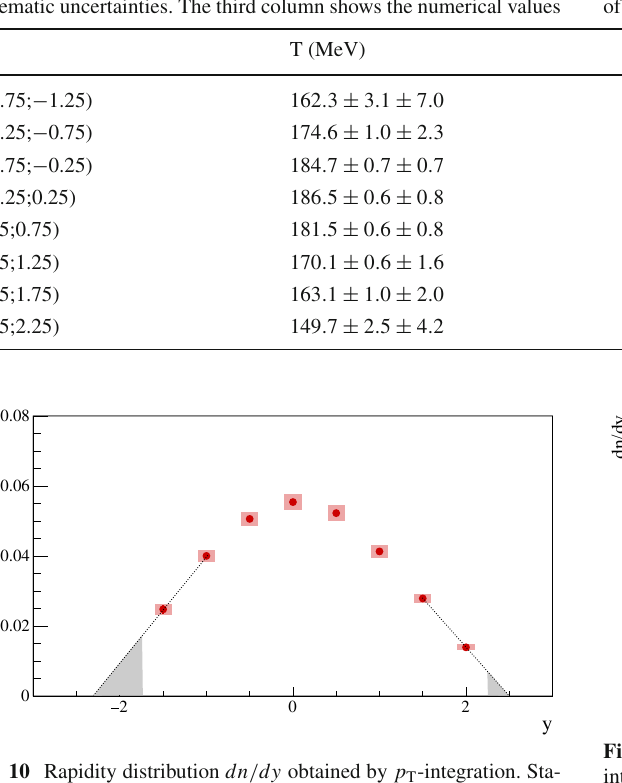
of the p T -integrated yields presented in Fig. 10 with statistical and sys- tematic uncertainties. In the last column contribution to the dn/dy in %